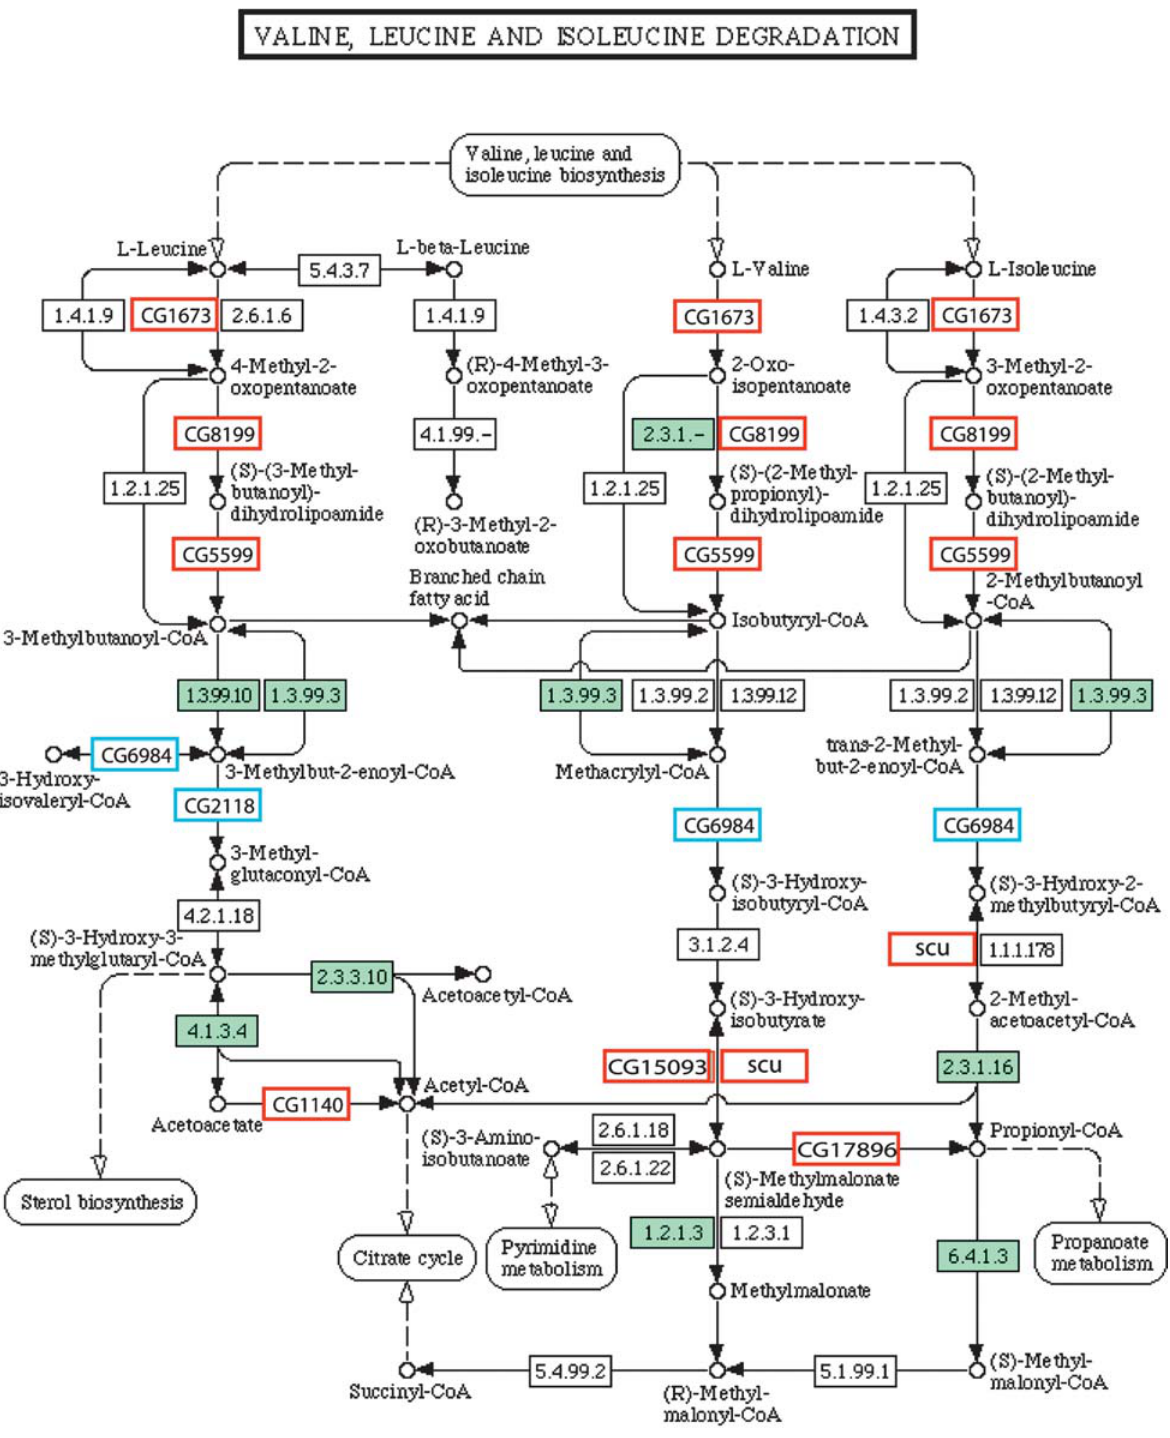
Figure 6. Valine, Leucine, and Isoleucine Catabolic Pathway Enzymes identified as miR-277 targets are boxed and identified by CG number. Red boxes required Z . 3 in Anopheles . Blue boxes required Z . 2 in Anopheles . In addition to the predicted targets, the other enzymes for which the gene has been identified in Drosophila are shaded in green. The metabolic pathway chart is from www.genome.ad.jp/kegg/pathway/map/map00280.html. DOI: 10.1371/journal.pbio.0000060.g006